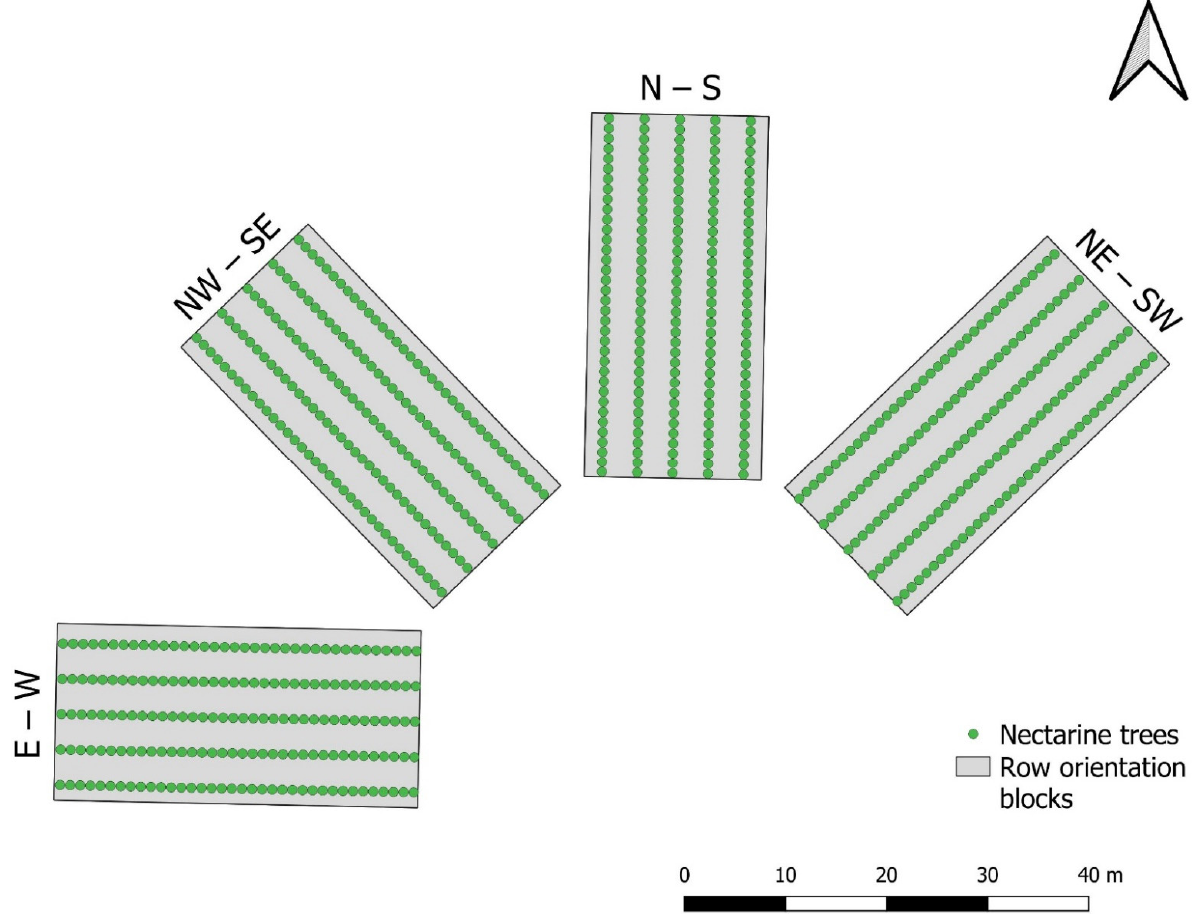
Figure 4. Spatial map of four row orientations and 720 ‘Majestic Pearl’ nectarine trees (180 trees per row orientation block) in the Sundial orchard at the Tatura SmartFarm.